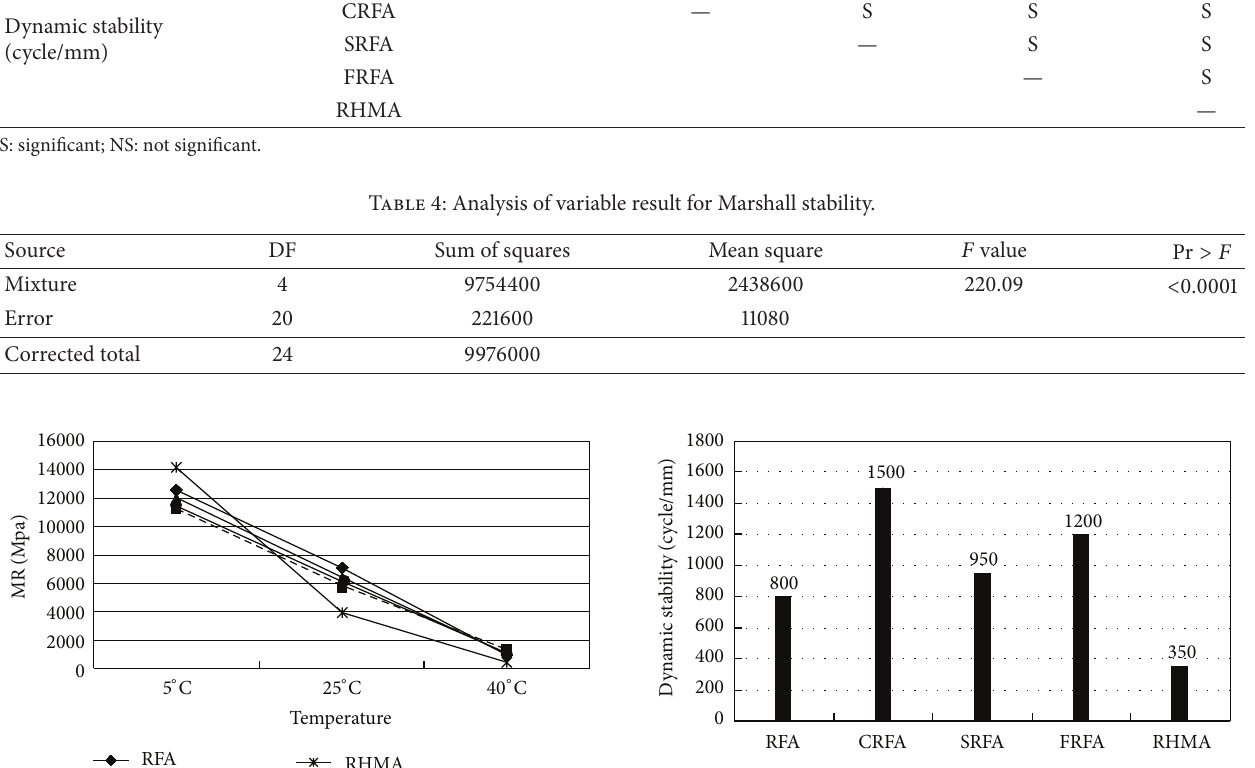
Figure 10: Wheel tracking test